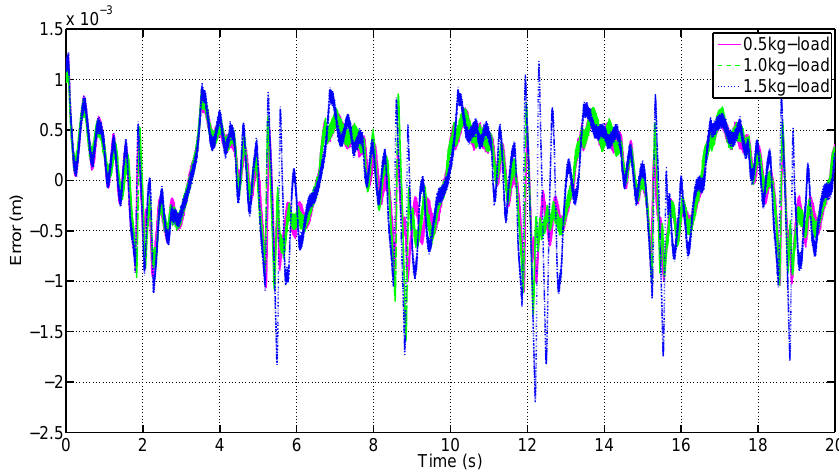
Figure 6. The tracking performance of the PMA with different loads.